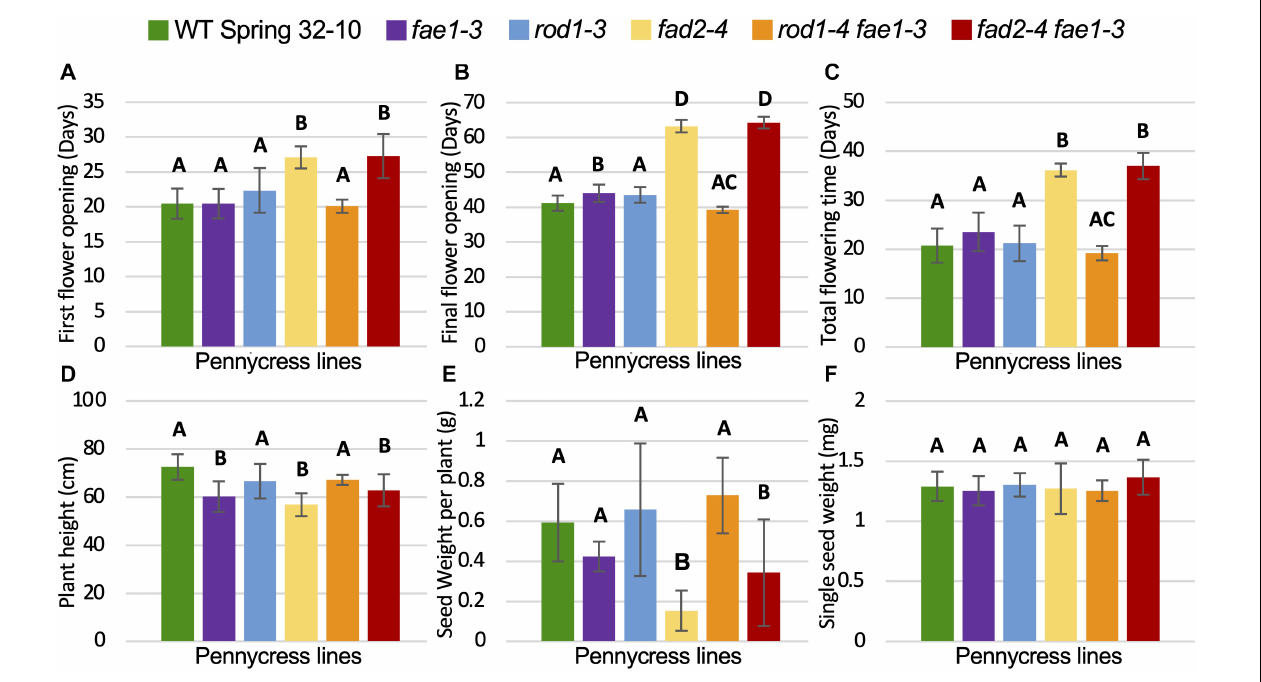
FIGURE 3 | Plant growth and seed yield comparisons. (A–F) Graphs showing average (A) time until first flower opening, (B) time until final flower opening, (C) duration of flowering, (D) plant height upon senescence, (E) total weight of seeds per plant, and (F) single seed weight. Bars are standard deviations. Different letters above columns represent significant differences between genotypes (one-way ANOVA; Tukey test, p < 0.01). n = 11 biological reps. For (E,F) , all seeds from each plant were